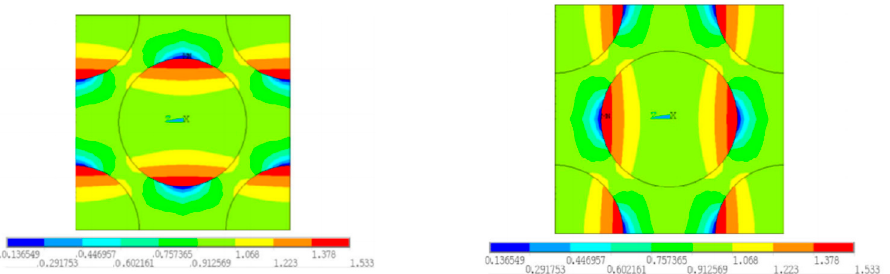
Figure 10. Stress distribution patterns for the model under unit stress loading along transverse direction in Ref. [37].